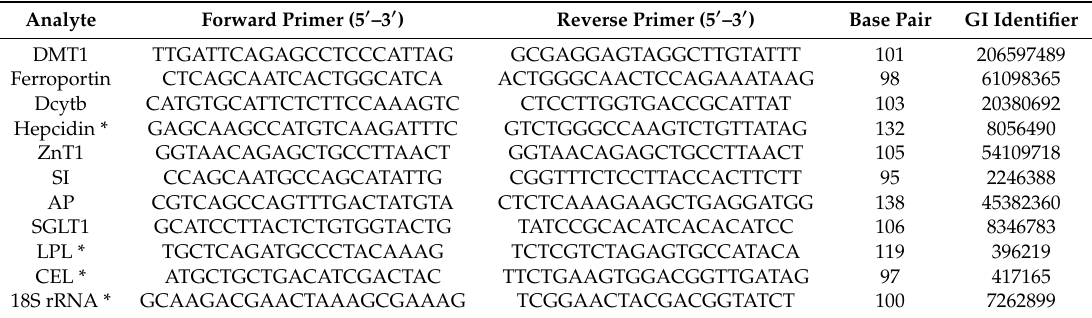
Table 1. The sequences of the primers used in this